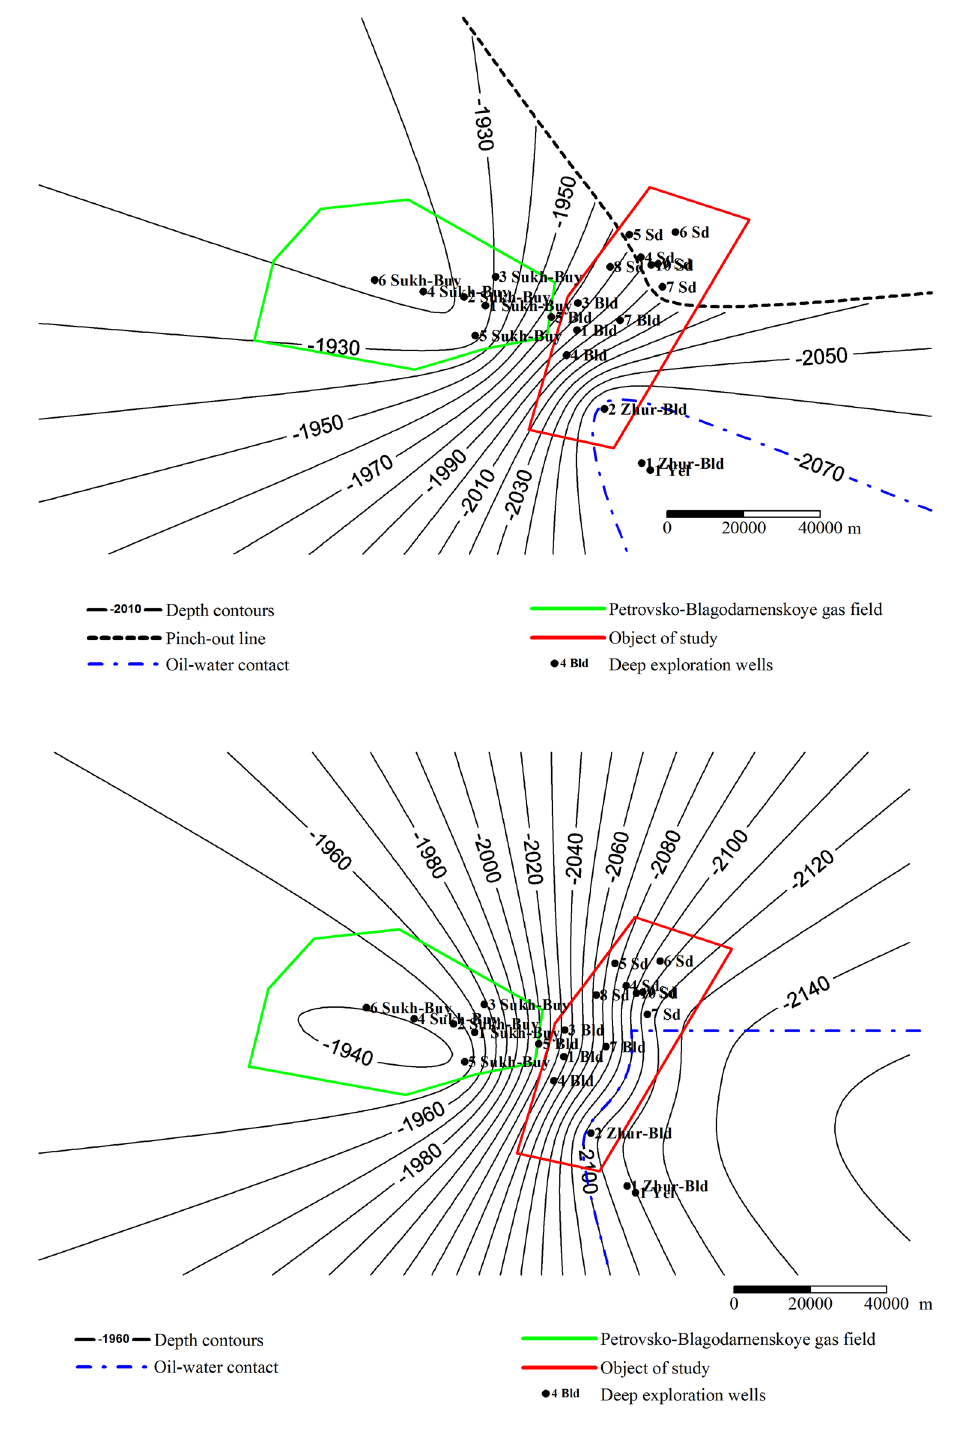
Fig. 8 Top of the Paleocene Layer I